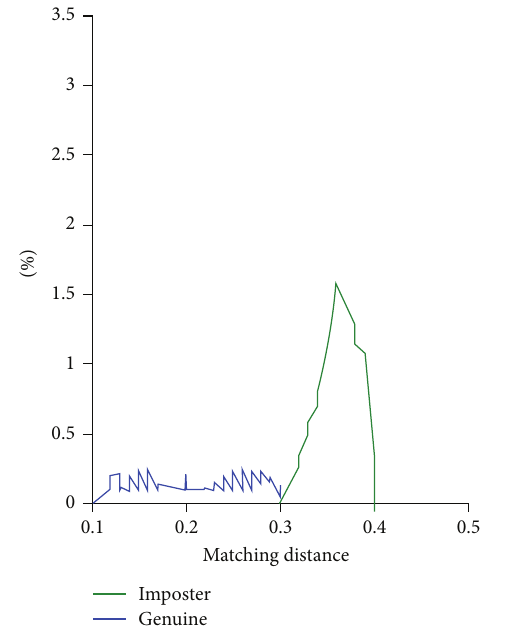
Figure22:Distancedistributionsofgenuinematchingandimposter matching of proposed DOST for IIT Delhi palmprint